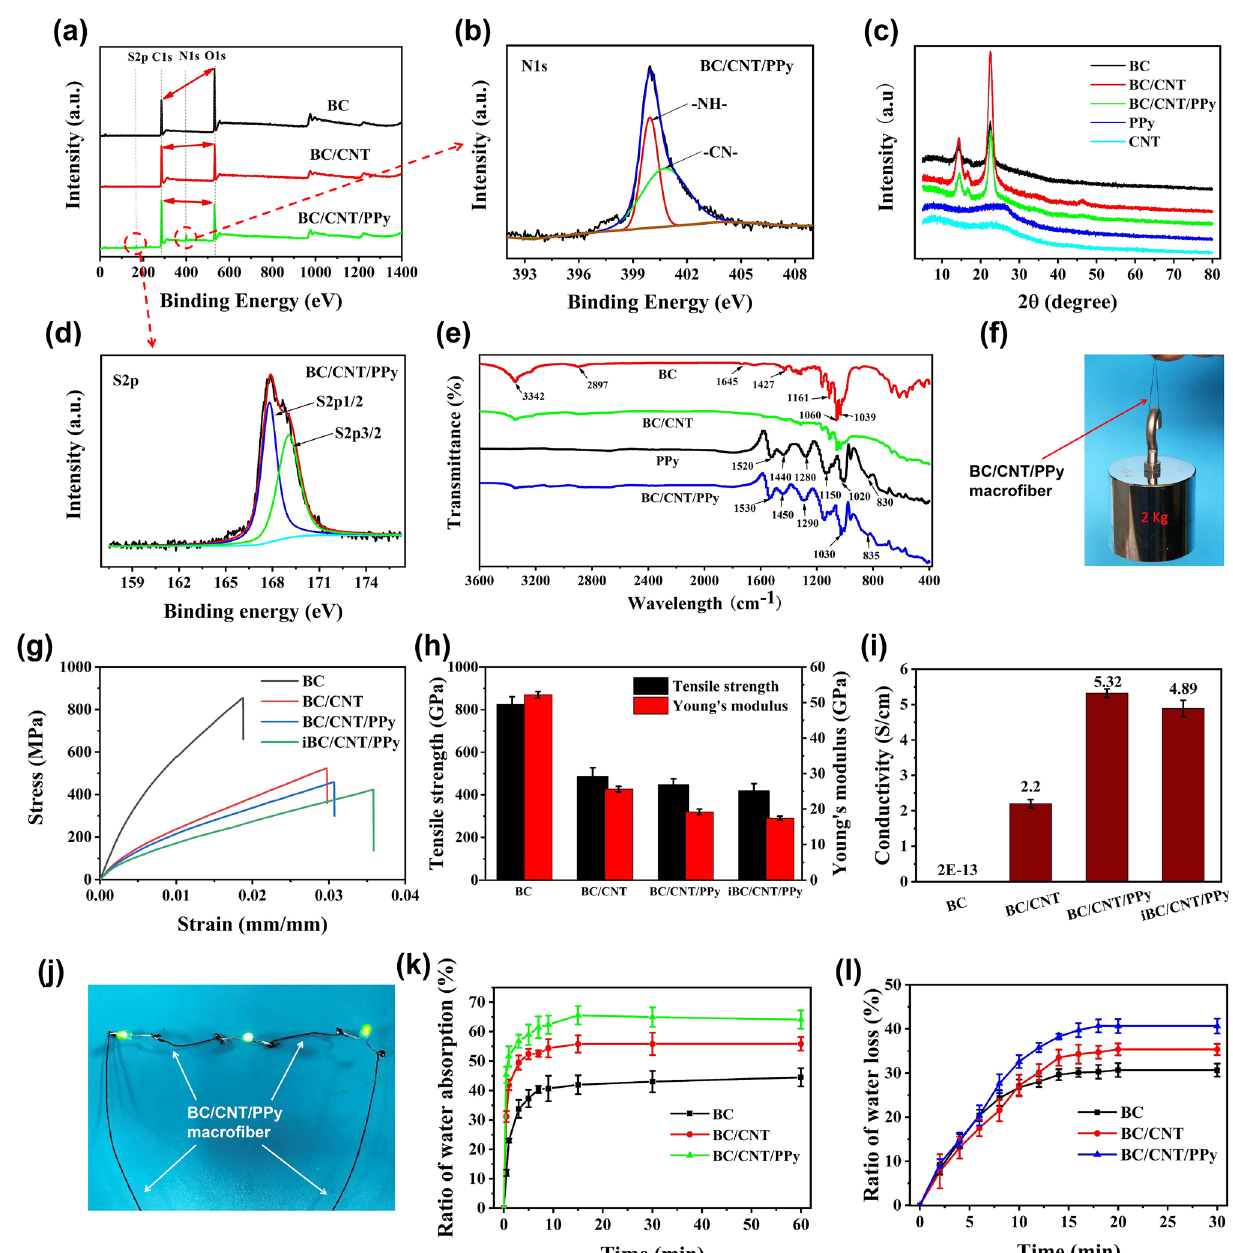
Fig. 3 a Wide scans measured for BC, BC/CNT, BC/CNT/PPy macrofibers, PPy and corresponding b N 1 s and d S 2 p core-level spectra of PPy and BC/CNT/PPy macrofiber. c XRD patterns of BC, BC/CNT, BC/CNT/PPy macrofiber, PPy, and CNT. e FTIR spectra of BC, BC/CNT, BC/CNT/PPy macrofibers, and PPy. f BC/CNT/PPy macrofiber lift 2 kg weight. g Stress–strain curves, and h tensile strength and Young’s modulus of BC, BC/CNT, BC/CNT/PPy, and iBC/CNT/PPy macrofibers. i The electrical conductivity of BC, BC/CNT, BC/CNT/PPy, and iBC/ CNT/PPy macrofibers. j BC/CNT/PPy macrofibers as a conductive yarn to light up LED when the power is turned on. The ratio of water absorp- tion k and water loss l of BC, BC/CNT and BC/CNT/PPy